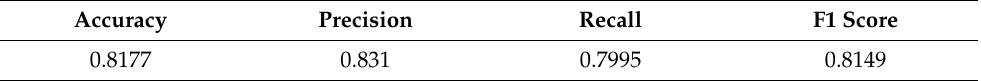
Table 5. Model training results for the first scenario.